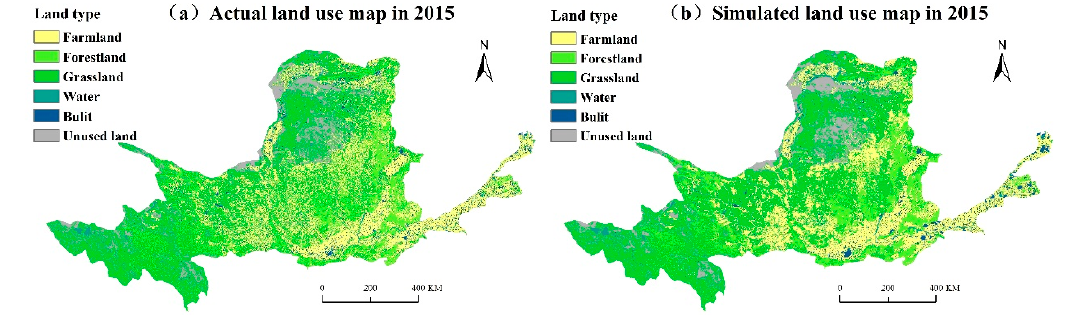
Figure 9. Comparison between simulated and actual land use maps in 2015. (4) The CROSSTAB module of IDRISI 17.2 software is used to calculate the Kappa coefficient (Figure 10), and the result is 0.82, indicating that the CA-Markov model can well simulate the land cover change in the Yellow River Basin;